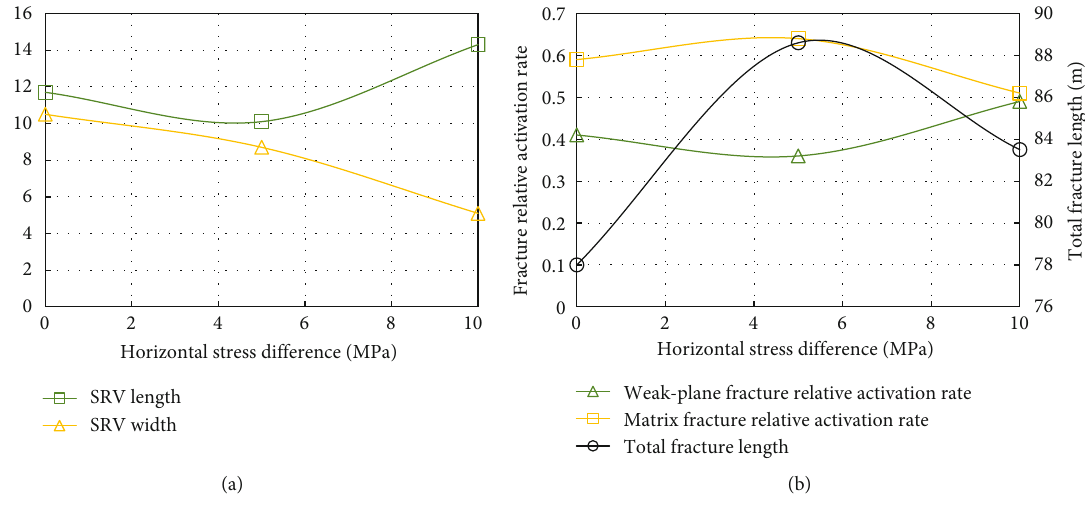
Figure 12: In fl uence of horizontal stress di ff erence on SRV (a) and fracture relative activation